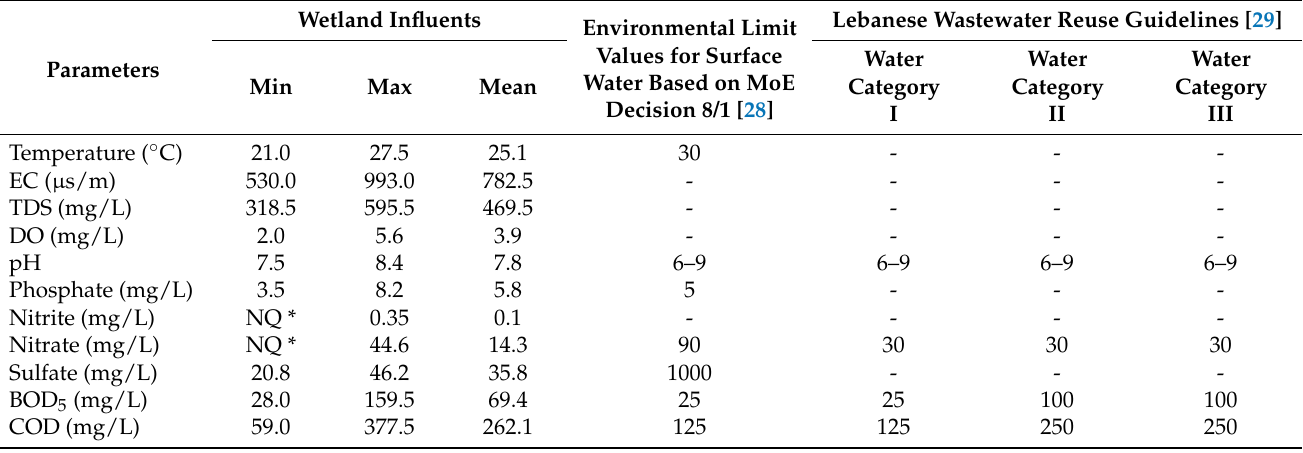
Table 1. Minimum, maximum, and mean value of water quality parameters collected from the wetland influent compared to recommended